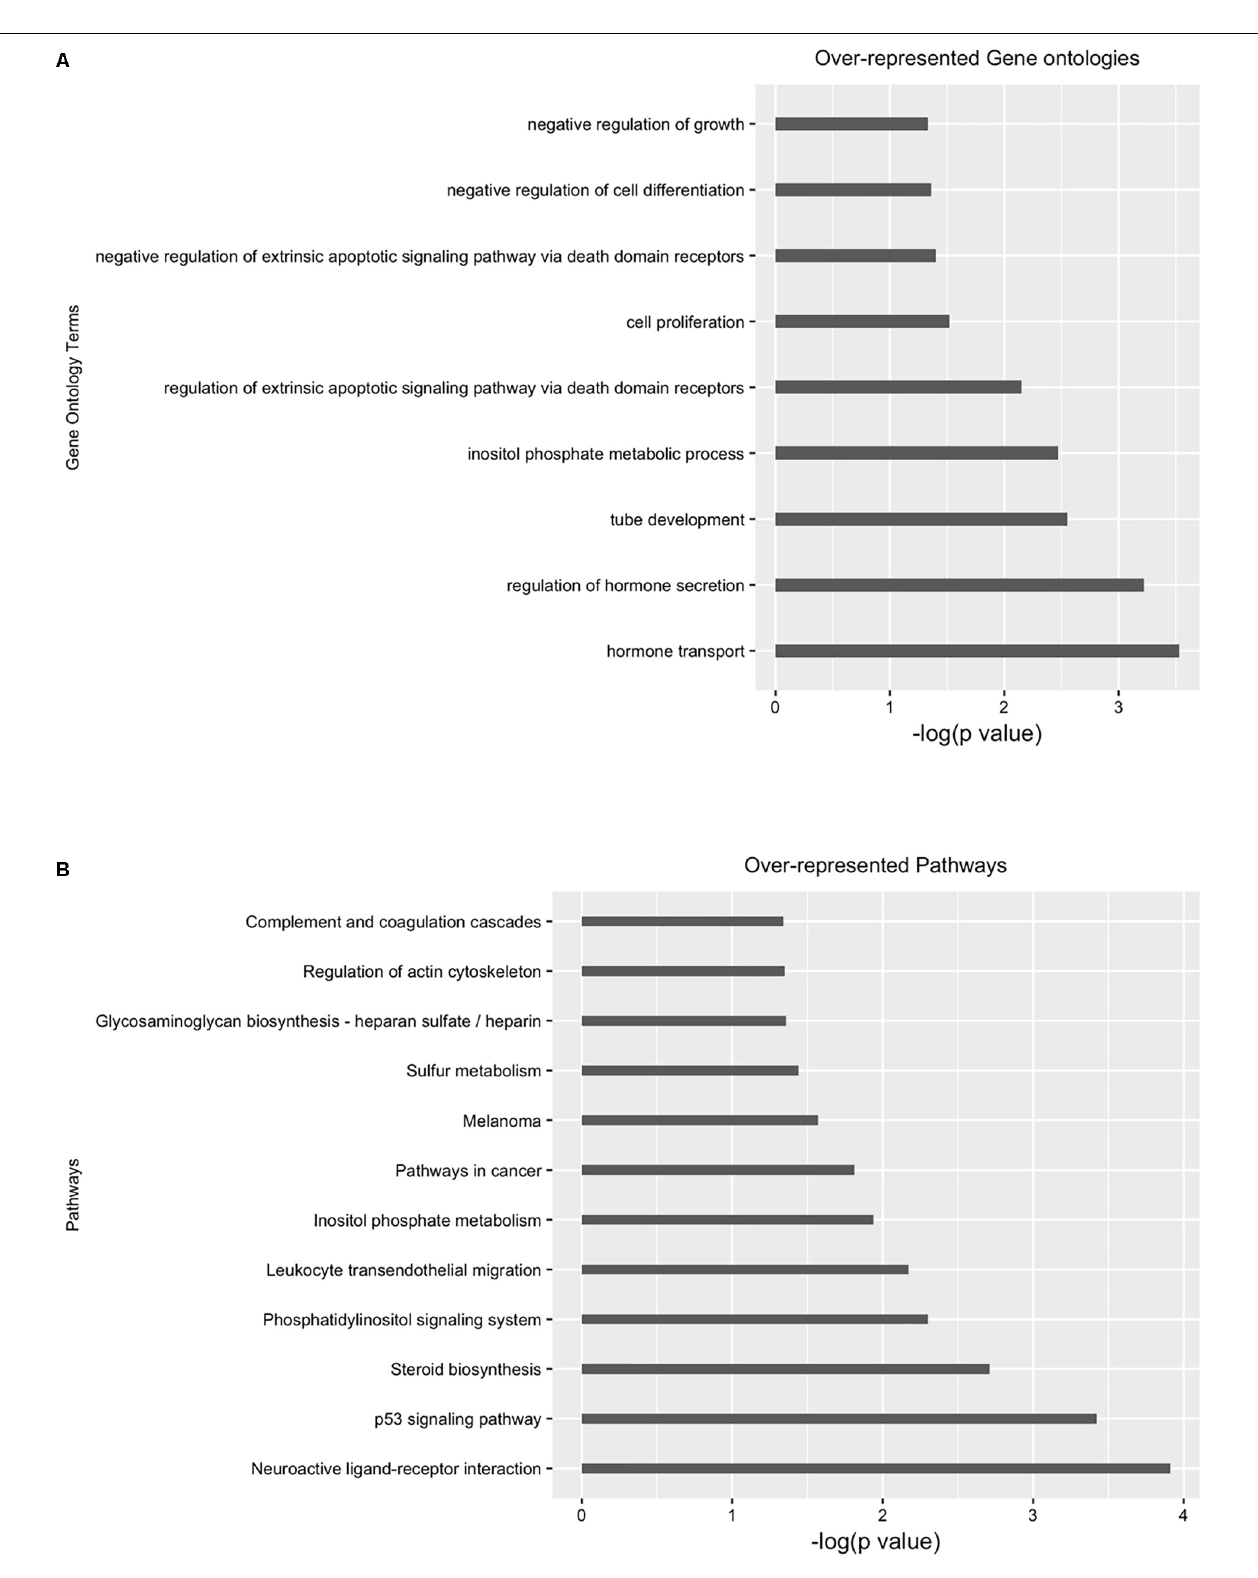
FIGURE 5 | Gene ontology (GO) and pathway analysis of differential enriched peaks. Differentially enriched peaks from Figure 4 were annotated with nearest downstream genes. Then these genes are used to perform (A) gene ontology and (B) pathway analysis.